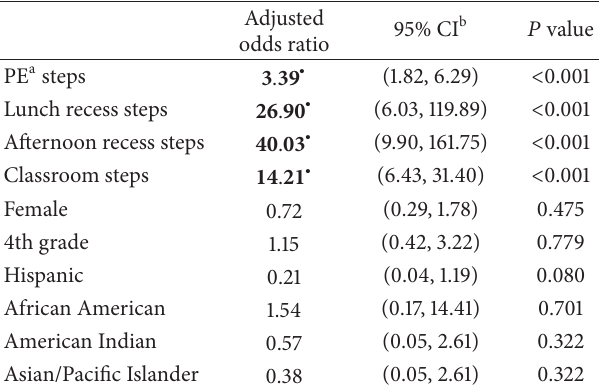
Table 2: Parameter estimates from the final fixed effects model solution using the school step target criterion (6,000